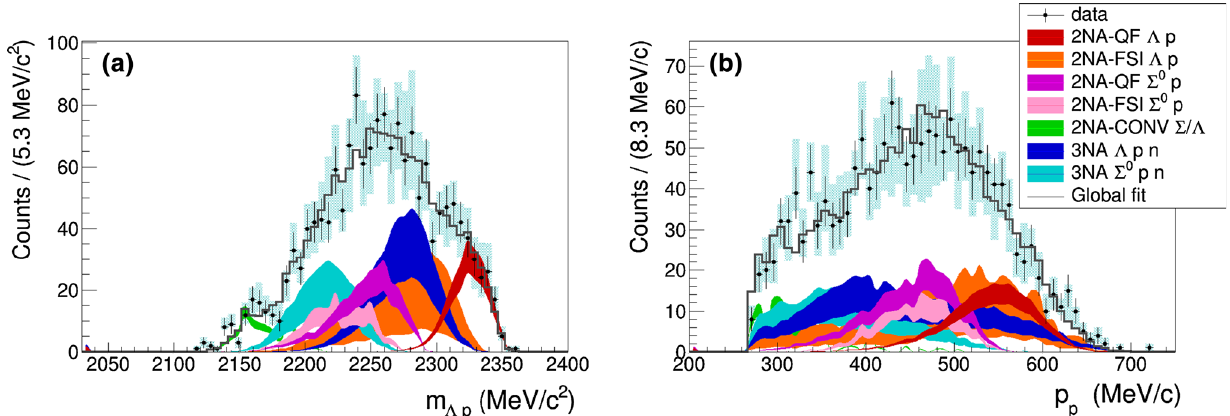
Fig. 9 (cid:2) p invariant mass ( a ) and proton momentum ( b ) spectra. Black points represent the data, black error bars correspond to the statistical errors, cyan error bars correspond to the systematic errors. The gray line